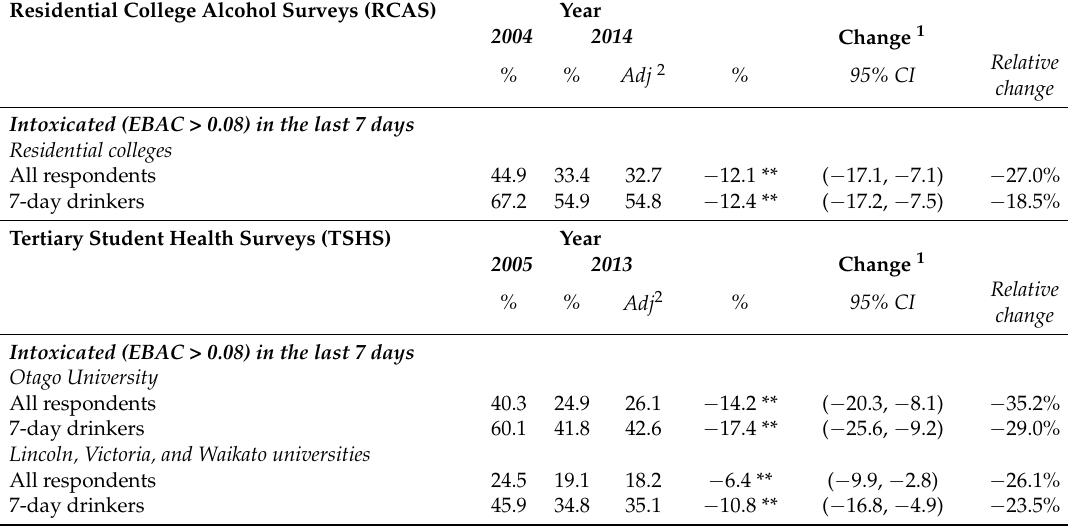
Table 3. Changes in the 7-day prevalence of intoxication between